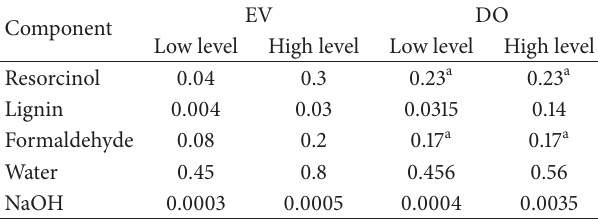
Table 1: Components levels in mass, first, and second design.